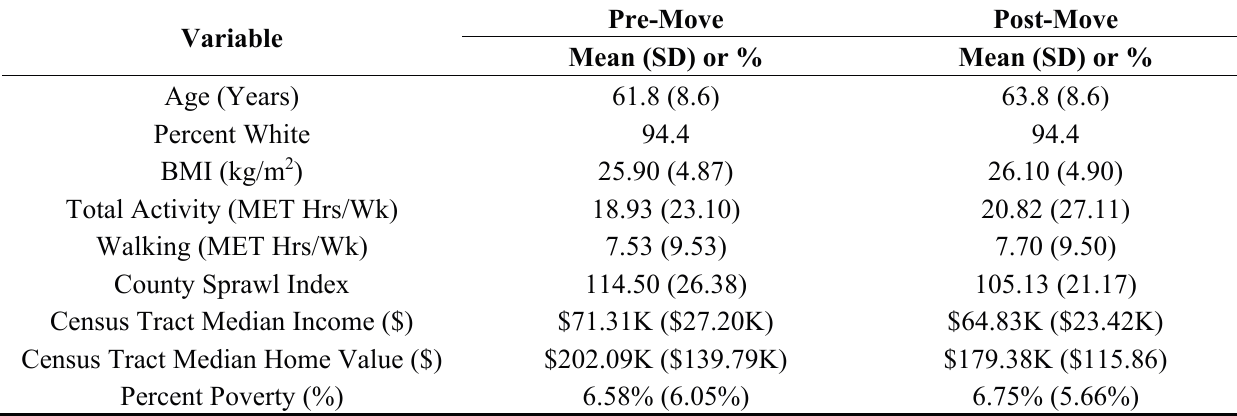
Table 1. Population characteristics of nurses’ health study participants (n = 14,159